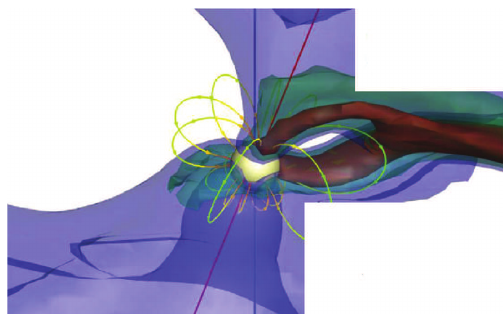
Figure 9: Model accretion flow in FL Ceti. The mag- netic field structure is calculated for a centered dipole plus strong quadrupole, where the component axes are aligned. The donor star is off the far right edge on the horizontal axis. The densest part of the flow is shown in brown. Accretion stream phasing is consistent with the observed pattern in FL Ceti, specifically the pre-eclipse dip and the existence of magnetic poles separated by ∼ 100 degrees. In the model, one spot is at the magnetic north pole while the other is near the intersection of the magnetic equator and the orbital plane. Similar flow patterns result for misaligned dipole and quadrupole components as